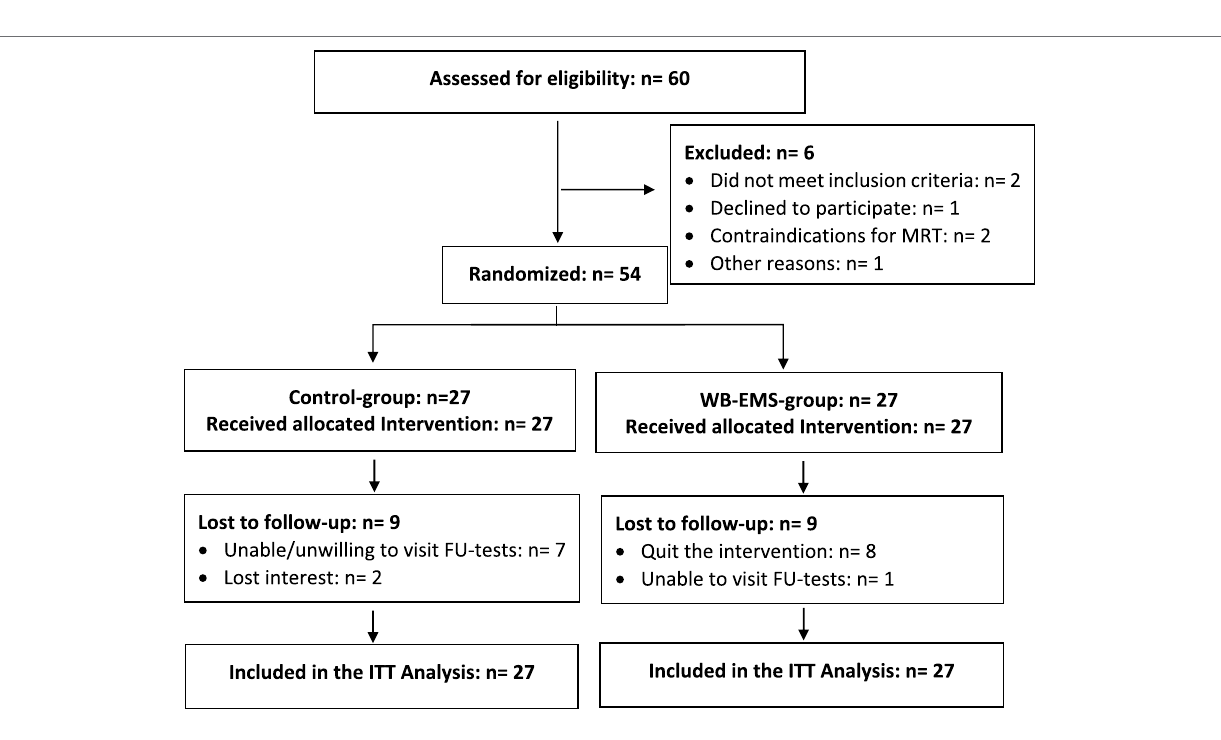
FIGURE 2 | Participants flow through the FrEMGo